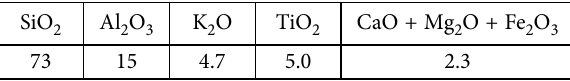
Table 1. Chemical composition of fluoroanhydrite, % СаО SO 3 CaF 2 SiO 2 А1 2 О 3 Fe 2 O 3 not less 35.0–36.5 than 45 Тable 2. Сhemical composition of expanded perlite sand, % SiO 2 Al 2 O